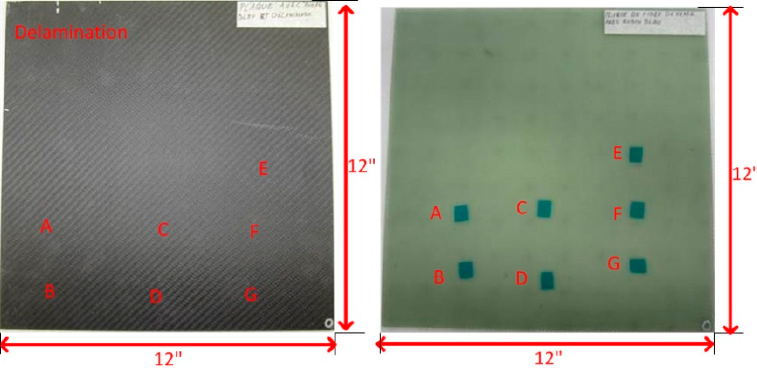
Figure 1. ( a ) The experimental CFRP specimen; ( b ) The corresponding CFRP Figure 1: (a) The experimental CFRP specimen, (b) the corresponding CFRP specimen.